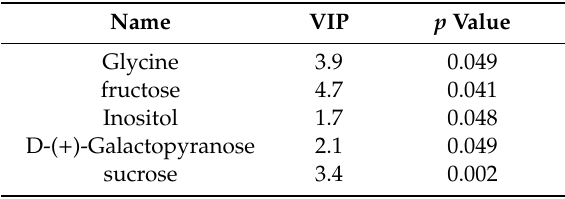
Table 5. Biomarkers of yeast cultures. VIP = very important parameter.